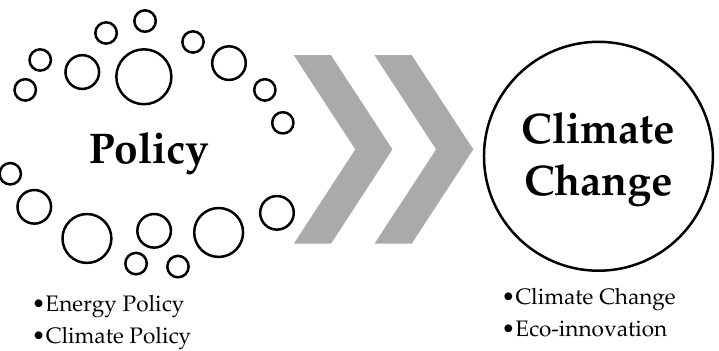
Figure 18. Main topics of Policy–Climate Change Clusters.